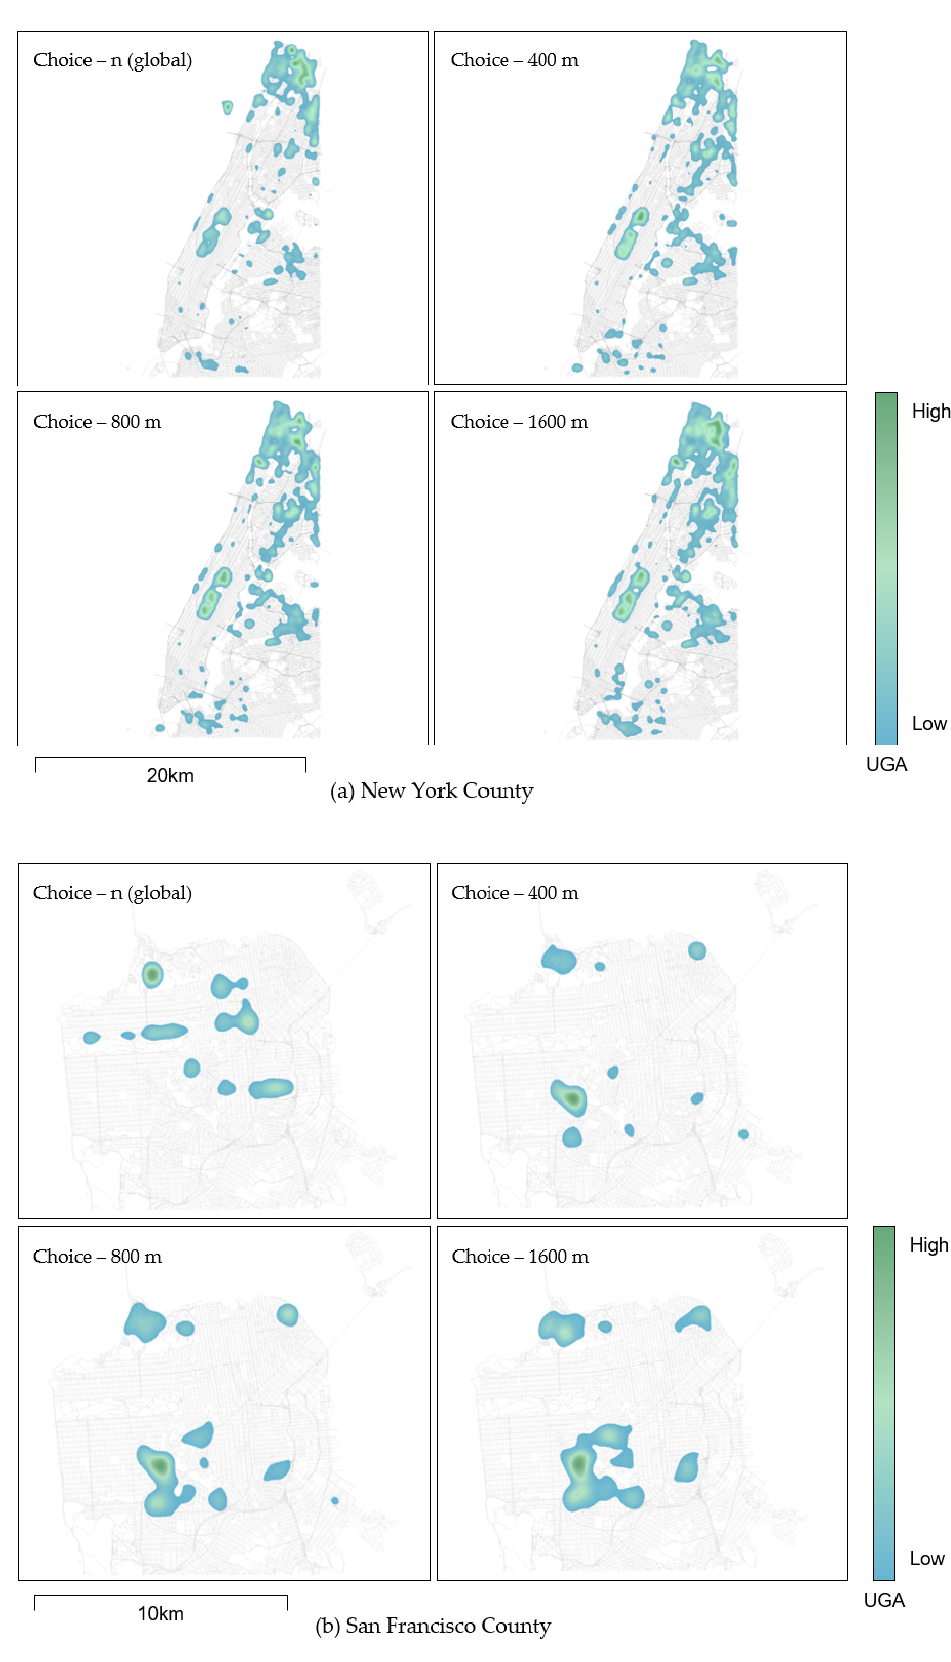
Figure 3. Urban green accessibility distribution with choice index applied as the topological